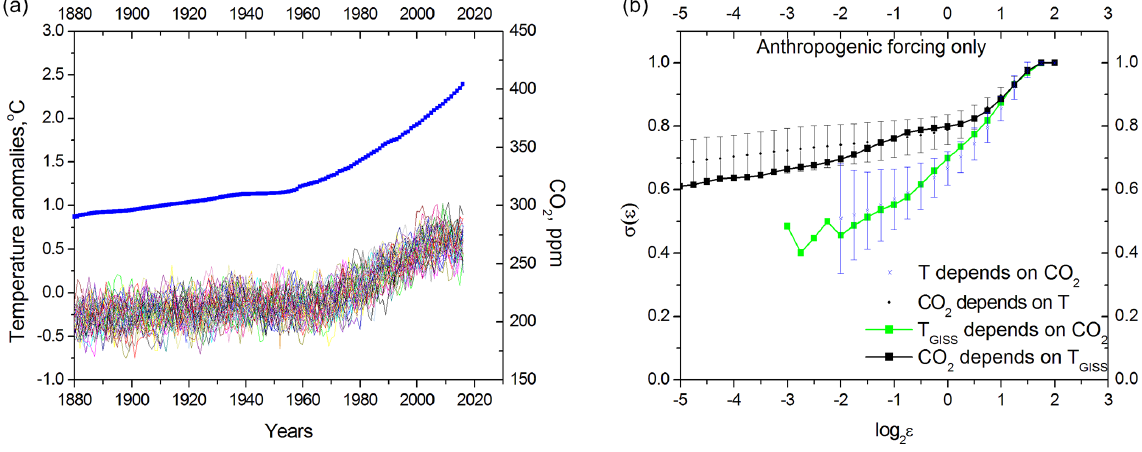
Figure 4. Same as in Fig. 3 but for anthropogenic CO 2 forcing only.